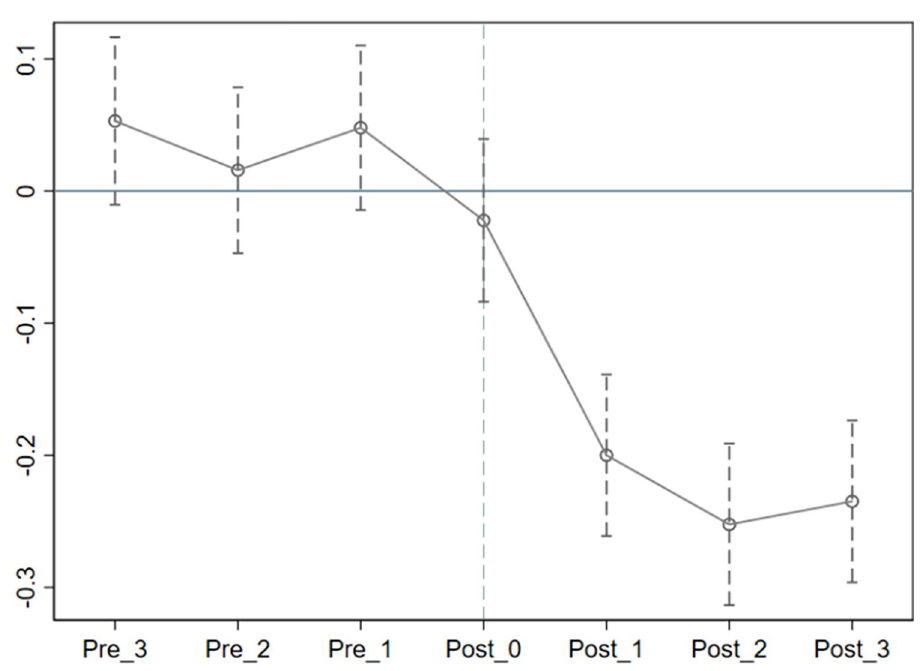
Fig 1. Parallel trend test of productivity of heavily polluting